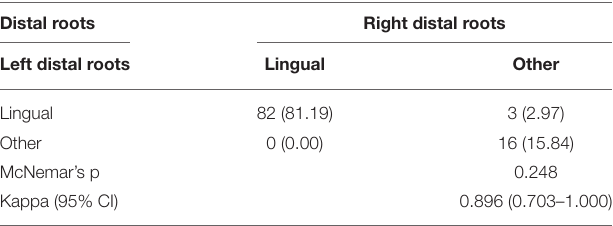
TABLE 3 | Evaluation of the same buccal-lingual relationship between the left and right distal tooth roots for each dog. Distal